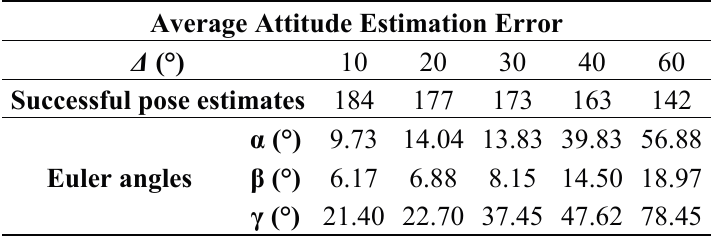
Table 2. On-line TM average estimation error in the relative Euler angles averaged over the successful pose estimates within the two-orbit sequence of